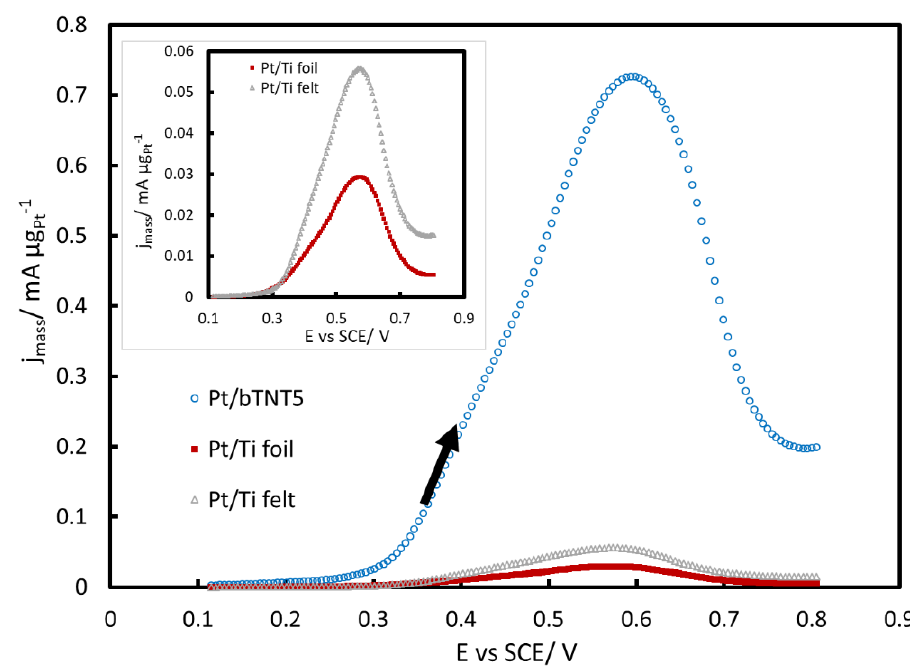
Figure 7. Voltammograms of Pt/bTNT5, Pt/Ti foil and Pt/Ti felt in a N 2 -deaerated solution of 0.1 M HClO 4 + 0.5 M MeOH, at a low scan rate of 5 mV s − 1 , scanned between +0.1–+0.8 V SCE (forward scans). The current is normalized per Pt mass in µ g. Inset; zoom at platinized Ti foil and felt.